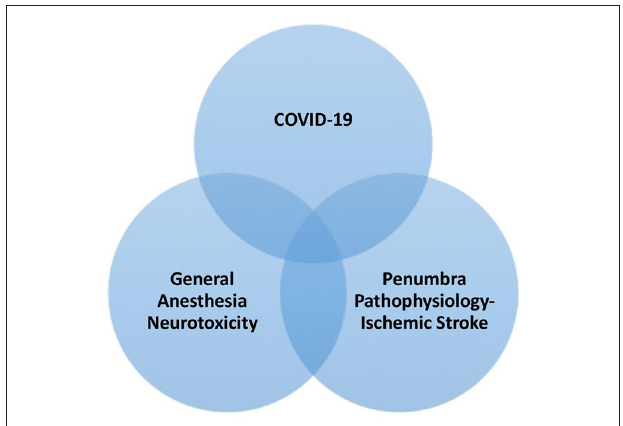
FIGURE 1 | The influence of COVID 19 on ischemic stroke during general